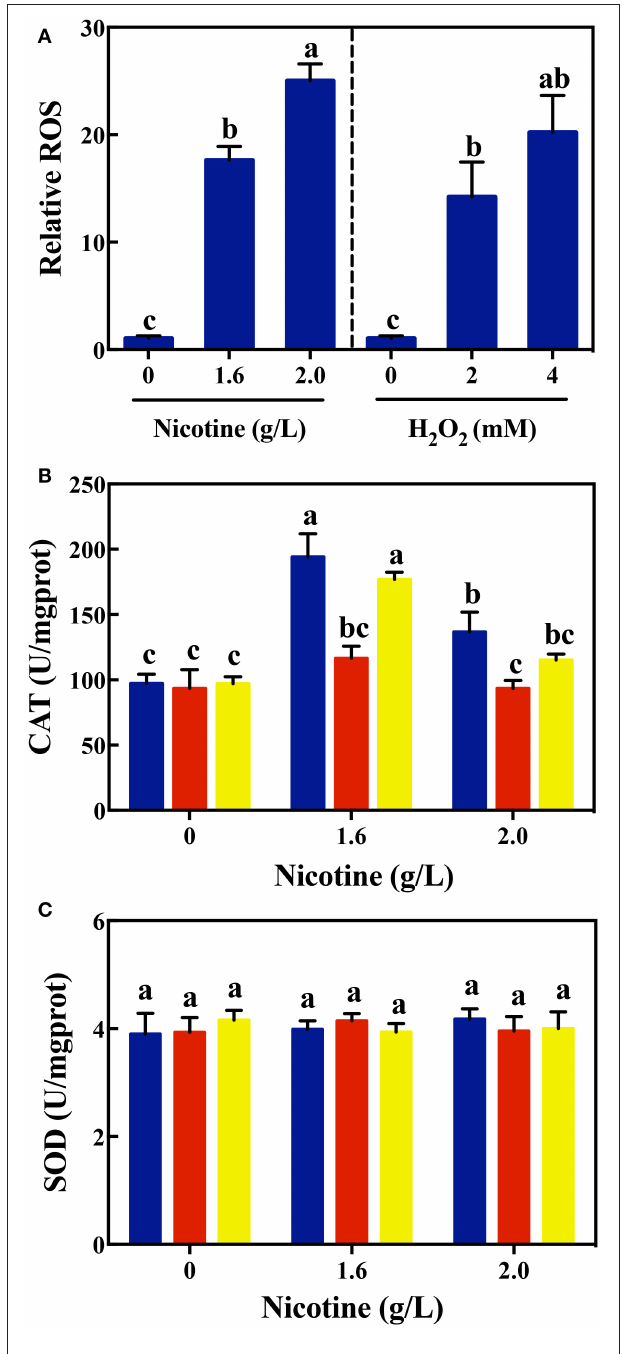
FIGURE 2 | Relative ROS levels (A) in WT on exposure to different concentrations of nicotine (left) and H 2 O 2 (right); CAT activity (B) and SOD activity (C) among different strains (WT, blue bars; 1 lasR , red bars; 1 rhlR , yellows bars) under exposure to different concentrations of nicotine. Different letters indicate significant difference at p < 0.05 and the same letter indicates no significant difference.